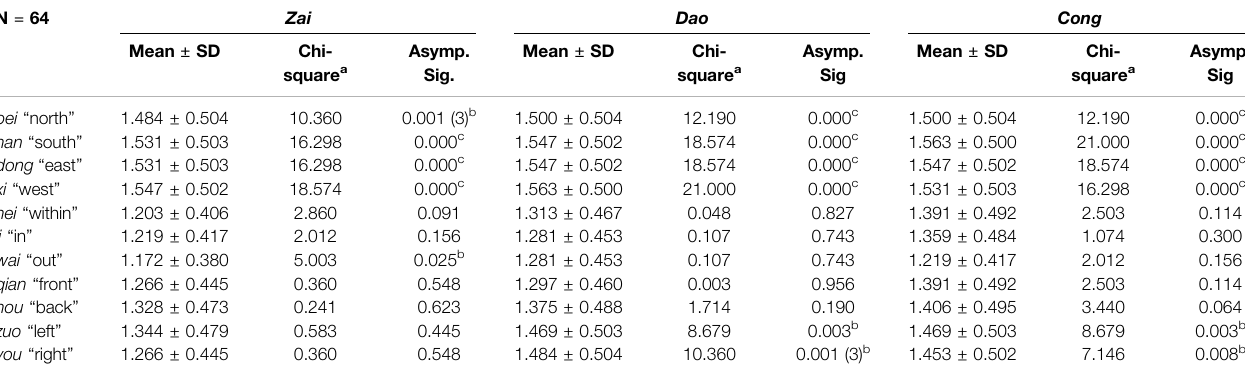
TABLE 1 | Descriptive statistics and chi-square test statistics of zai , dao , and cong . N = 64 Zai Dao Cong Asymp. Mean ± SD Chi- Sig. square a